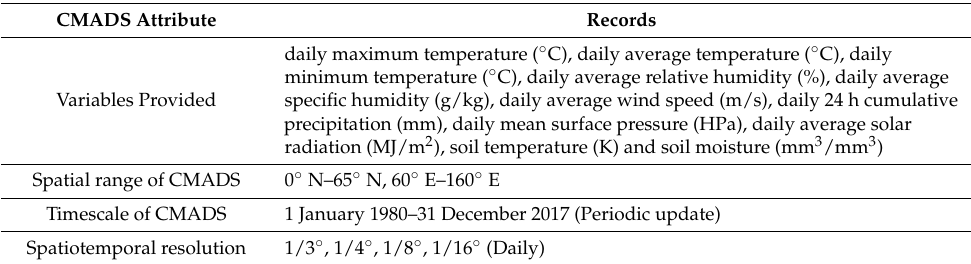
Table 1. The information on